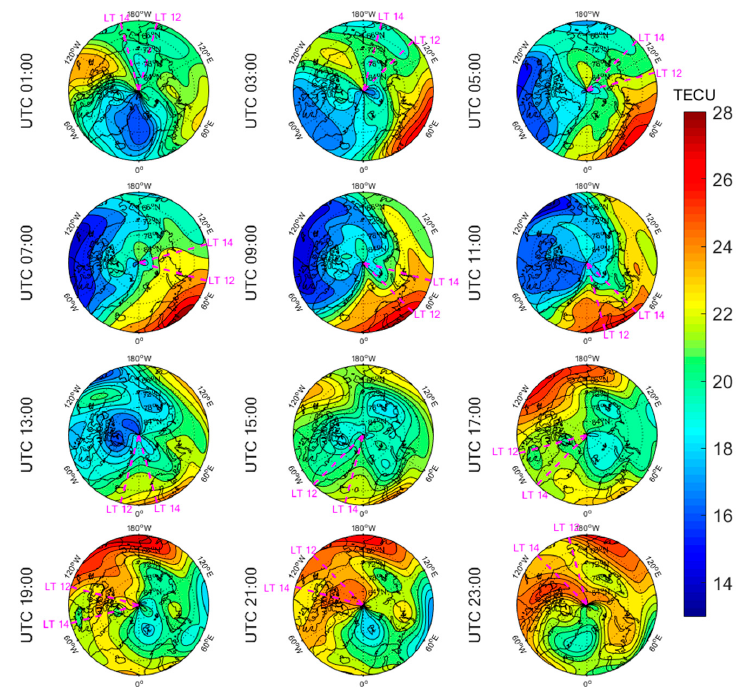
Figure 8. Spatial distribution of mapping TEC of 12 sections under high solar activity year, polar day (DOY 185 in 2014) over the Arctic. The magenta lines in each subplot represent the longitudes at 12:00 and 14:00 at the middle of the 2 h section of the corresponding subplot.